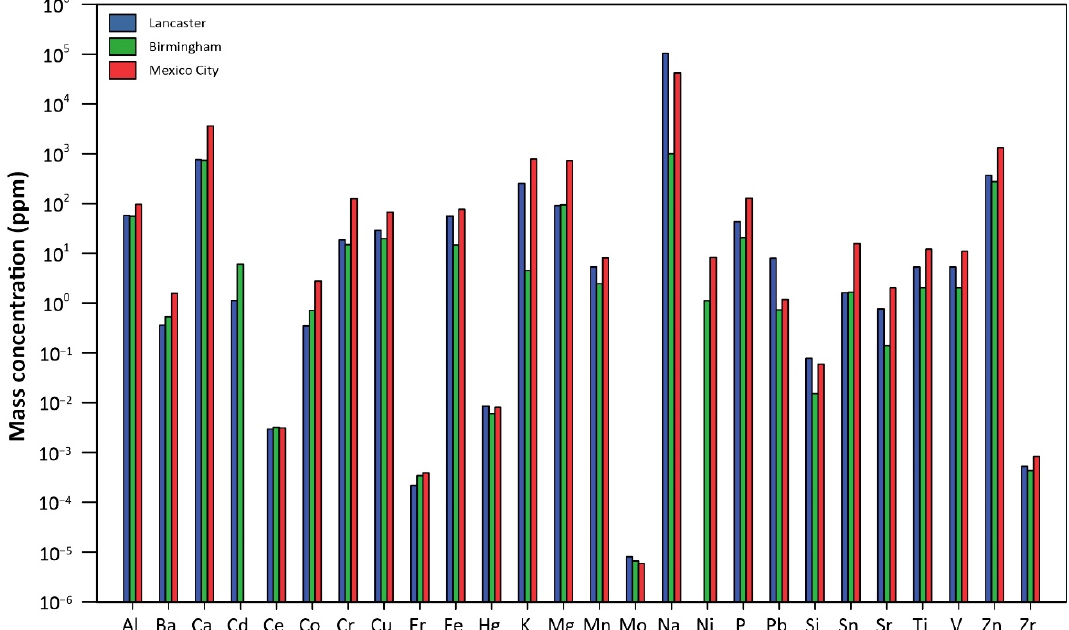
Figure 2. Elemental composition of the UF-RDPs from Lancaster, Birmingham, and Mexico City.